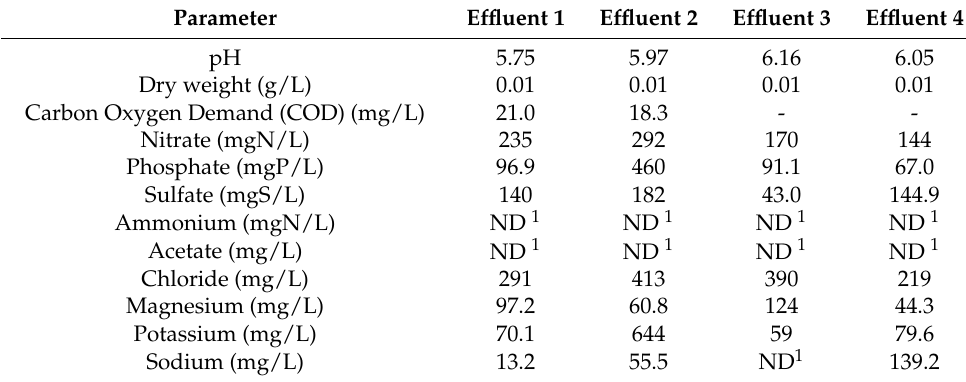
Table 1. Hydroponic farm wastewaters (HFWW) characterization.